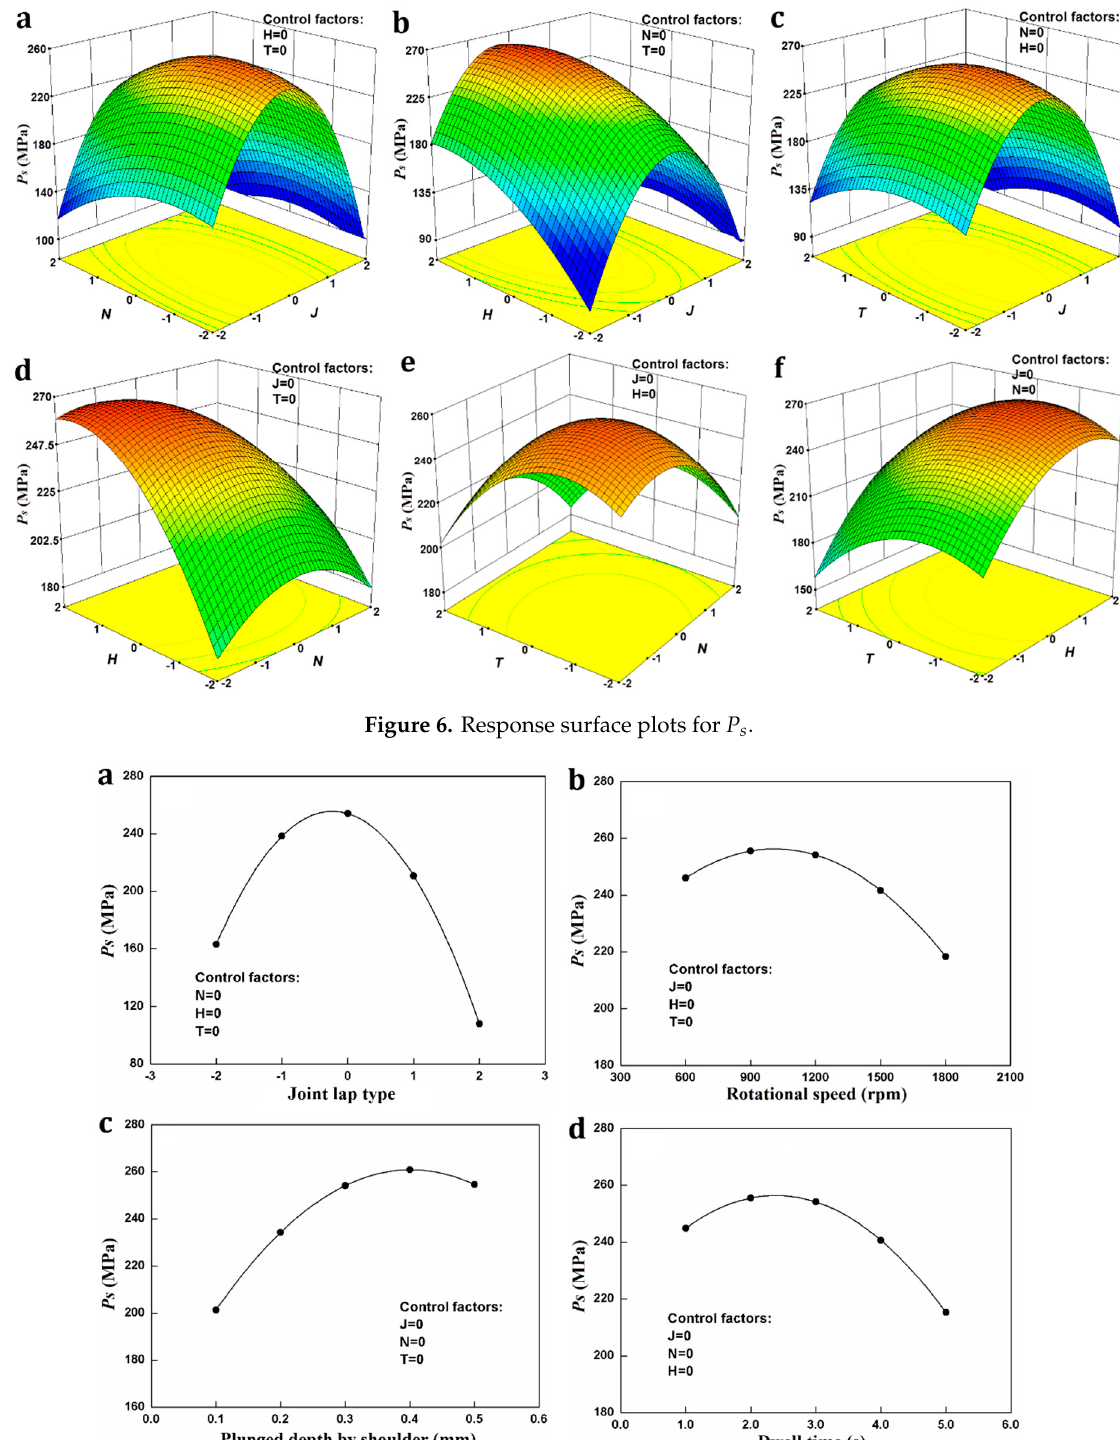
Figure 7. First-order main effect plots for P s .